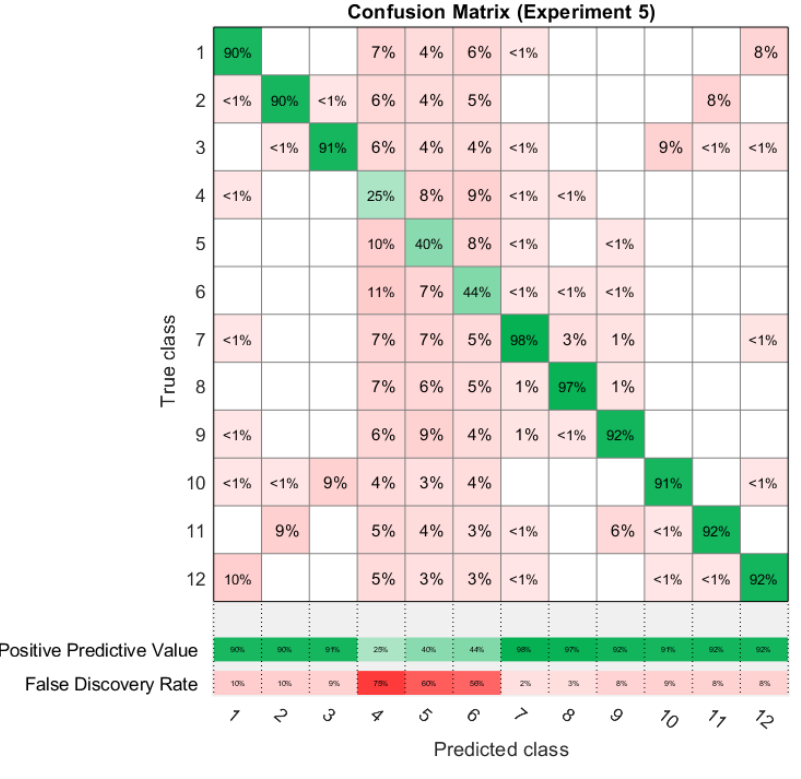
Figure 19. Confusion matrix. Experiment 5.